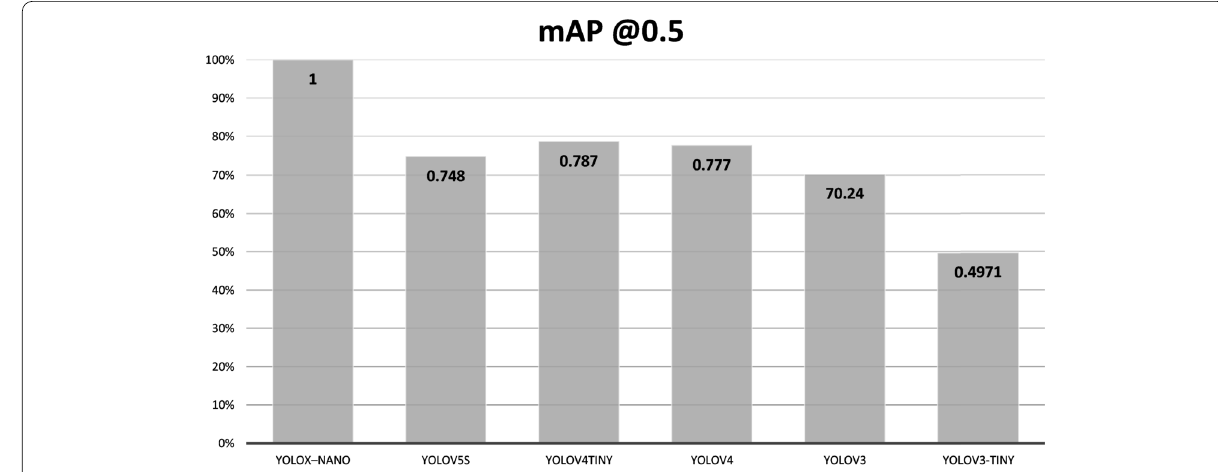
Figure 9 Comparison of Average Precision (AP) of different trained models